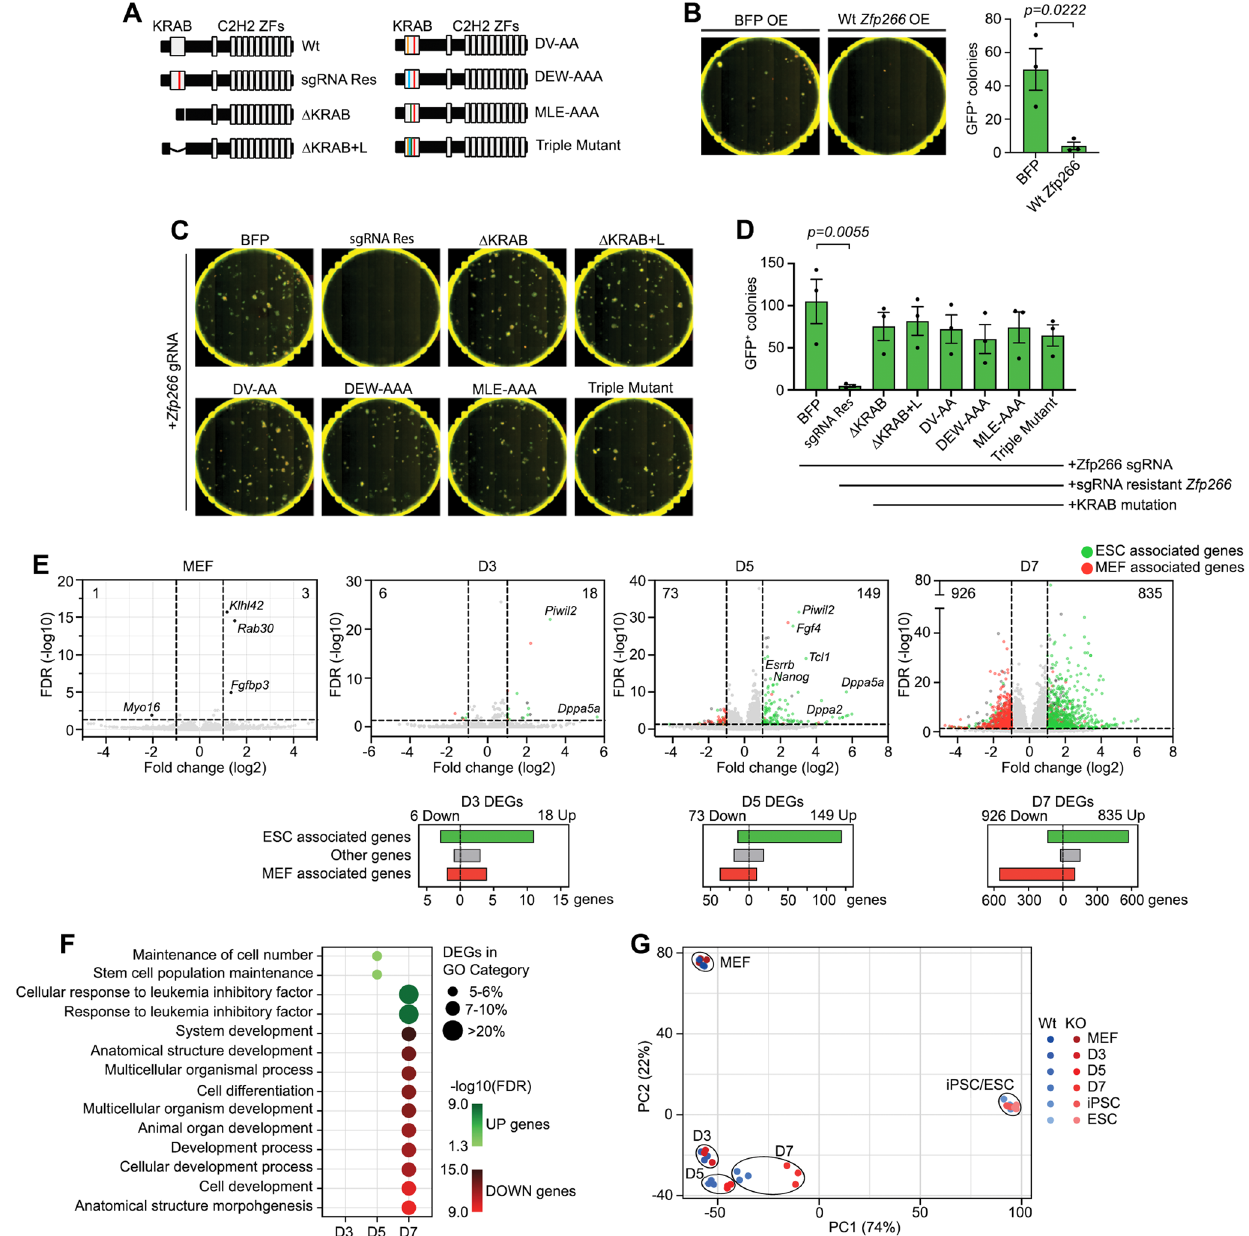
Fig.3|ZFP266impedesactivationofpluripotencygenesviaitsKRABdomain. A Diagram of Zfp266 Wt and mutants. A red bar indicates a silent mutation